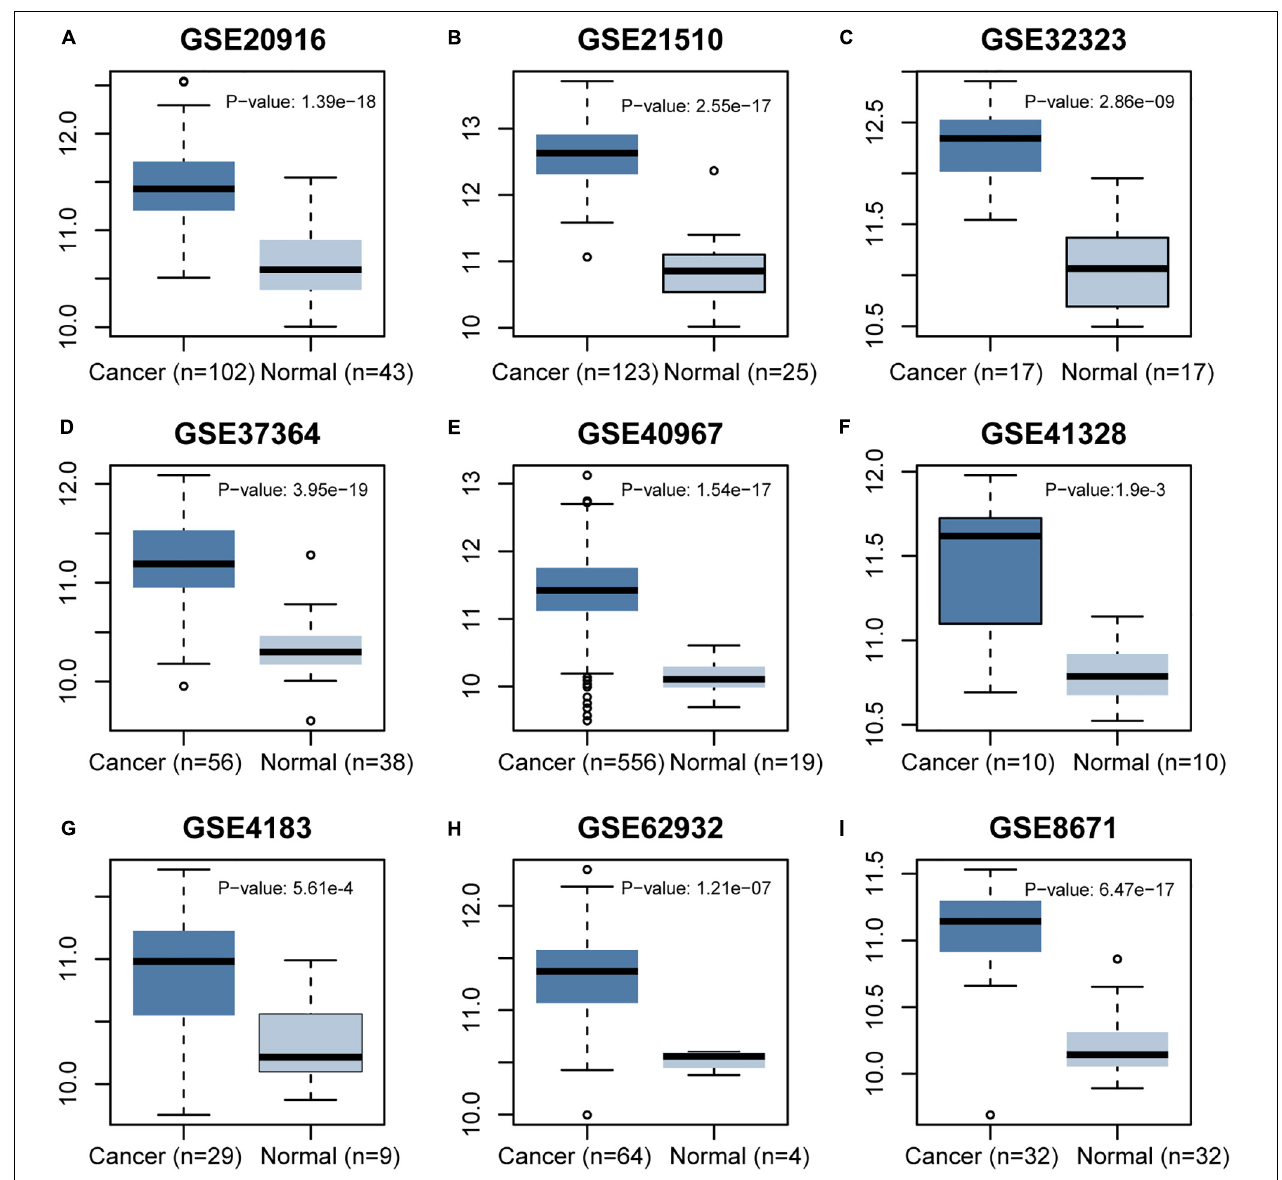
FIGURE 3 | Differential expression analysis of CCT6A gene in several COAD datasets of